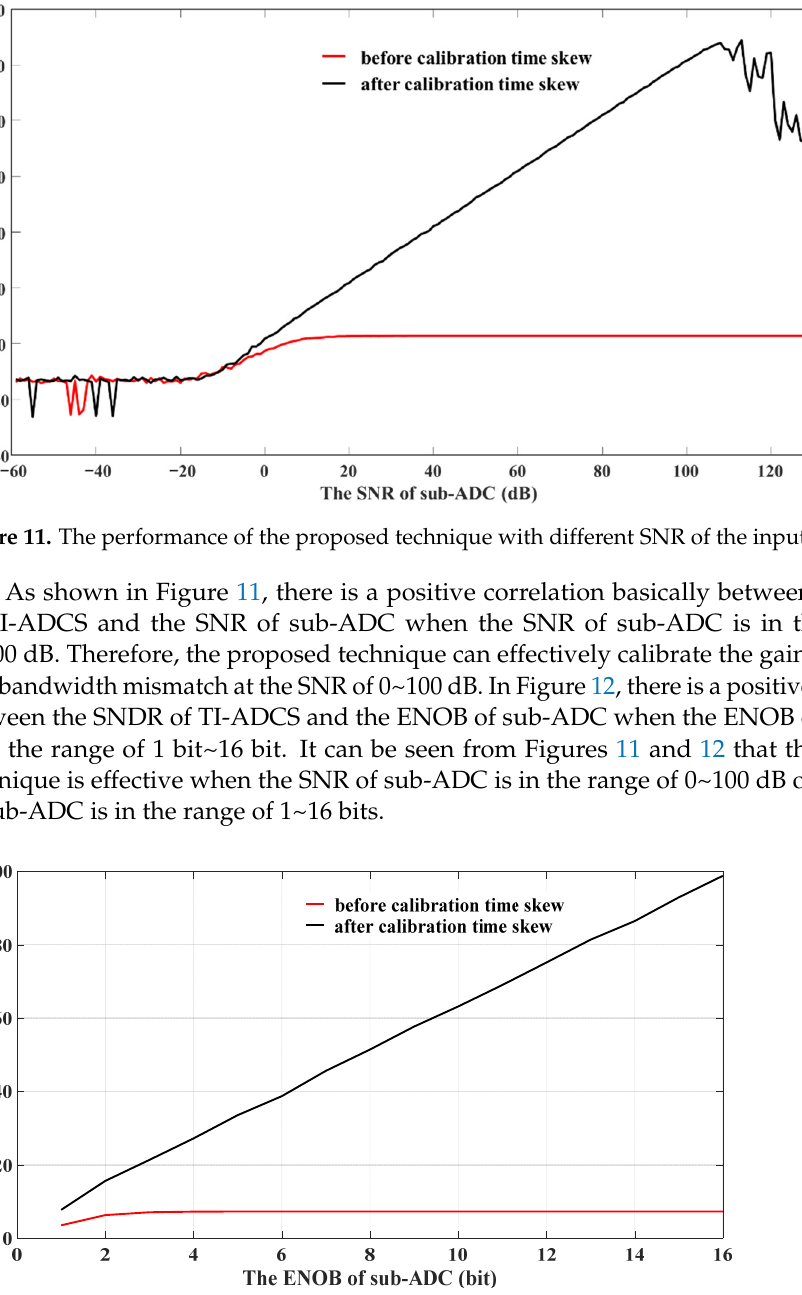
Figure 13. The cumulative errors under different SNR of the sub ‐ ADC in the proposed technique.